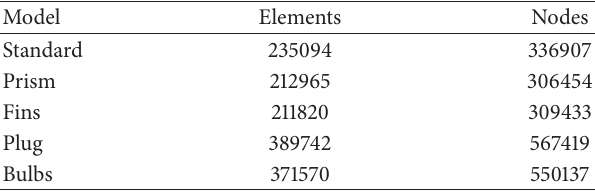
Fins, (4) targeted press-fit Plug, and (5) targeted press-fit Table 1: Number of elements and nodes used in the 5 FE